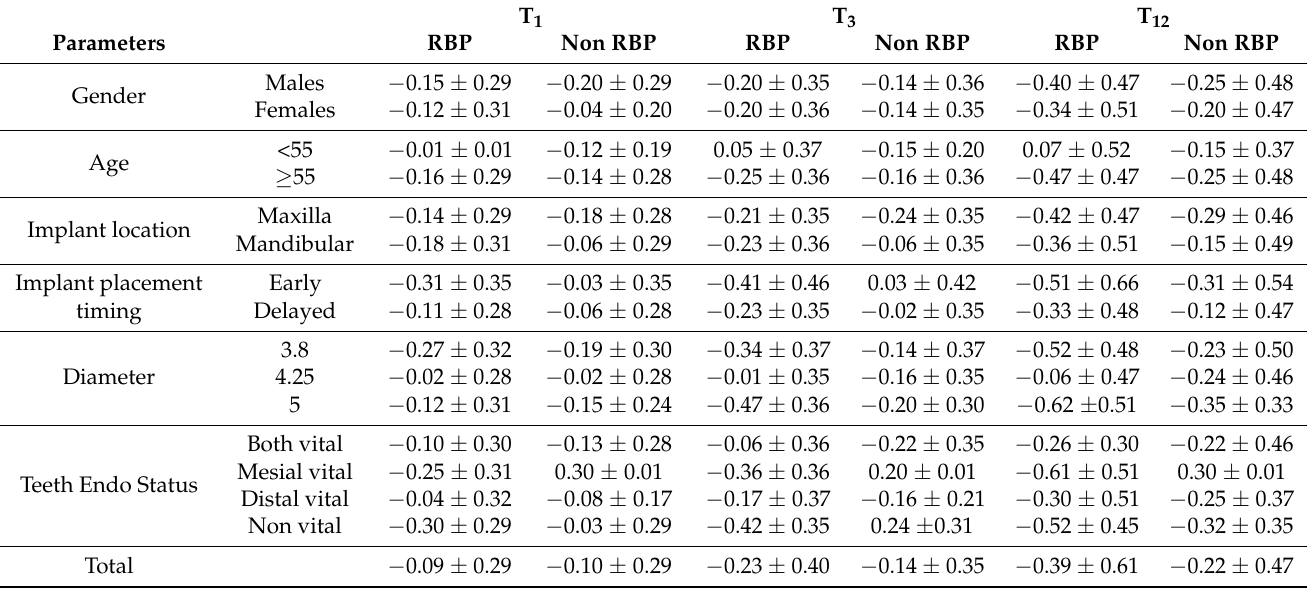
Table 4. Mean ± SD values of the Cement Enamel Junction (CEJ) at 1, 3 and 12 months.